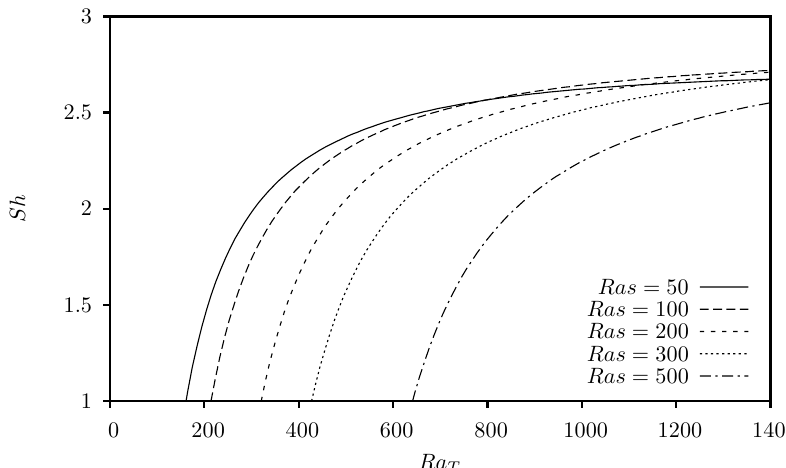
Figure 16. Variation of Sh with Ra T for steady nonlinear stability: effect of Ras for Du = 0.05, Sr = 0.005, Ri = 1, Le =